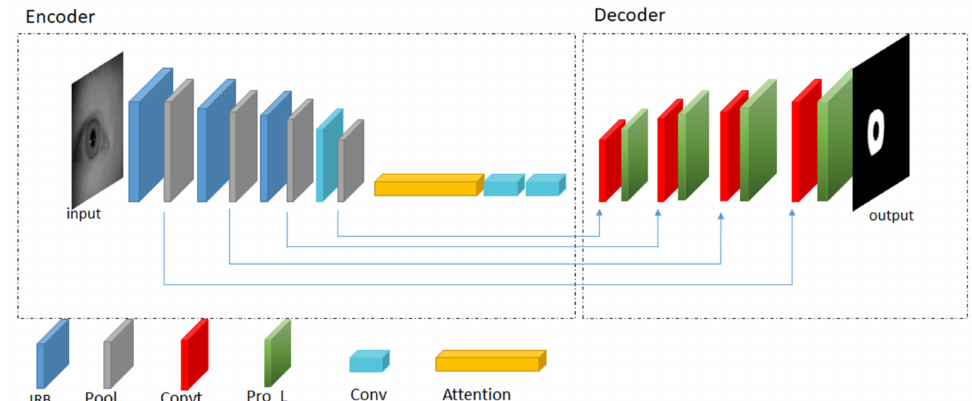
Figure 2. The architecture of self-designed IRUNet. The abbreviation ‘IRB’, ‘Pool’, ‘Convt’, ‘Pro_L’, ‘Conv’, and Attention stands for interleaved residual block layers, pooling layers, transpose convolutional layers, process layers, convolutional layers, and attention module, respectively.